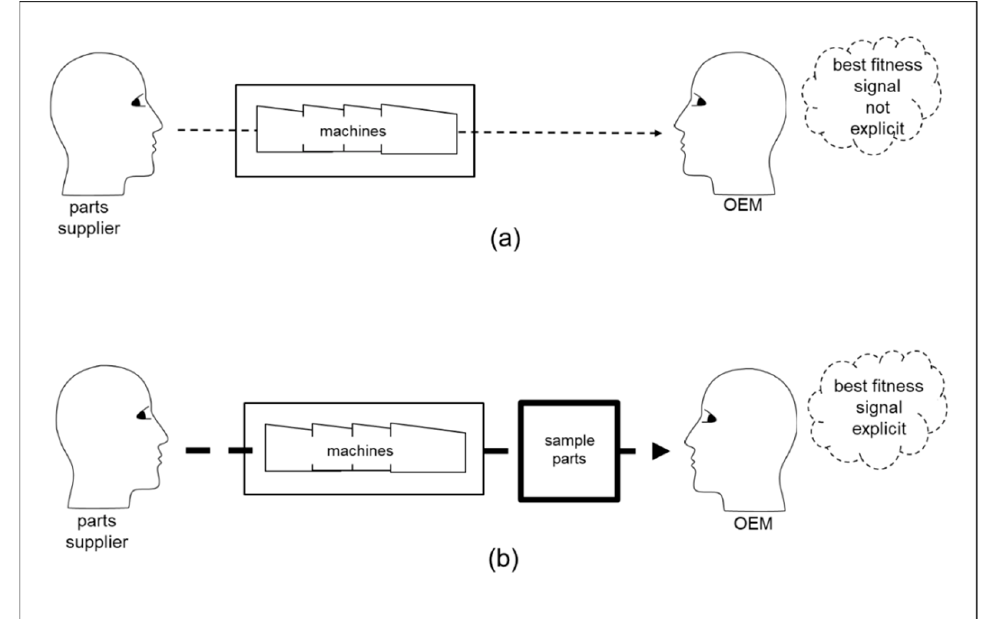
Figure 3. Complexity/accuracy trade-off. ( a ) The OEM’s model is too complex because the OEM has multiple inferential steps in trying to relate manufacturing facilities to the parts to be manufactured. Hence, the OEM’s prediction accuracy about the parts supplier is not well enabled. ( b ) The OEM’s model is less complex because the OEM has fewer inferential steps due to the parts supplier having made explicit what was implicit and implied in ( a ) by investing in sector-specific component samples as well as premises and machines. Hence, the OEM’s prediction accuracy is facilitated.